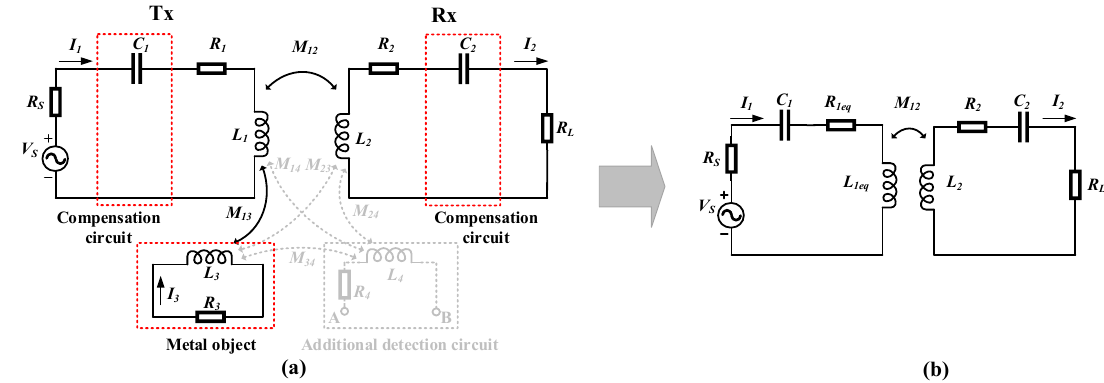
Figure 6. ( a ) complete circuit, ( b ) equivalent circuit of the WPT system considering the effect of a metal object.